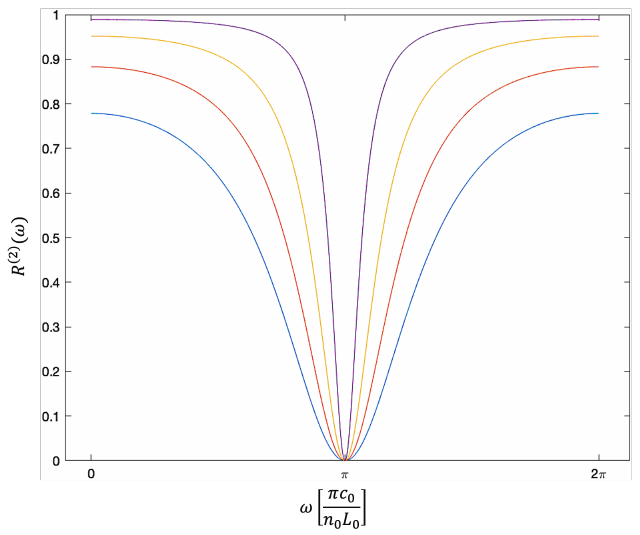
Figure 6. The dependence of the overall reflection rate R ( 2 ) ( ω ) in Equation (23) on the on the frequency ω of the incoming light. Here, we consider symmetric mirrors without absorption and choose all reflection and transmission rates as suggested in Equation (22). In addition, we assume that | r ( 2 ) | 2 = | r ( 2 ) | 2 = 0.36 (blue), 0.49 (red), 0.64 (yellow) and 0.81 (purple). The figure shows the typical a c reflection spectrum of a Fabry-Pérot cavity. At the resonance frequency of the resonator, R ( 2 ) ( ω ) = 0, independent of the reflection rates of the two mirrors. Increasing the mirror reflection rates, increases the quality factor Q of the cavity and results in a narrower downwards peak in the cavity resonance fluorescence spectrum R ( ω )